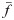
Predictions of the FM-feedback spectral model for FM-sweeps.A) Heatmaps show the mean activation at different cochlear channels as simulated by a model of the auditory periphery in response to each sweep; units are arbitrary. Error bars point to the expected value and standard deviation of the distribution across frequencies for each sweep. Each empty square denotes the expected channel elicited by a pure tone with the frequency of the average experimental data of the corresponding sweep. B) Predictions of the standard deviation of the perceived pitch. Error bars are estimations of standard error of the model calculated based on the dispersion of the centroids for different f‾ and the standard deviations of the spectral distribution ρ of each condition. Kernel density estimations are the same experimental data as in Fig 1B. C) Predictions of the standard deviation and up/down asymmetry. Error bars show the model predictions of the up/down asymmetry coefficient asymm↑↓ (see Eq (1)) in the channel space. Kernel density estimations are the same experimental data as in Fig 1C.